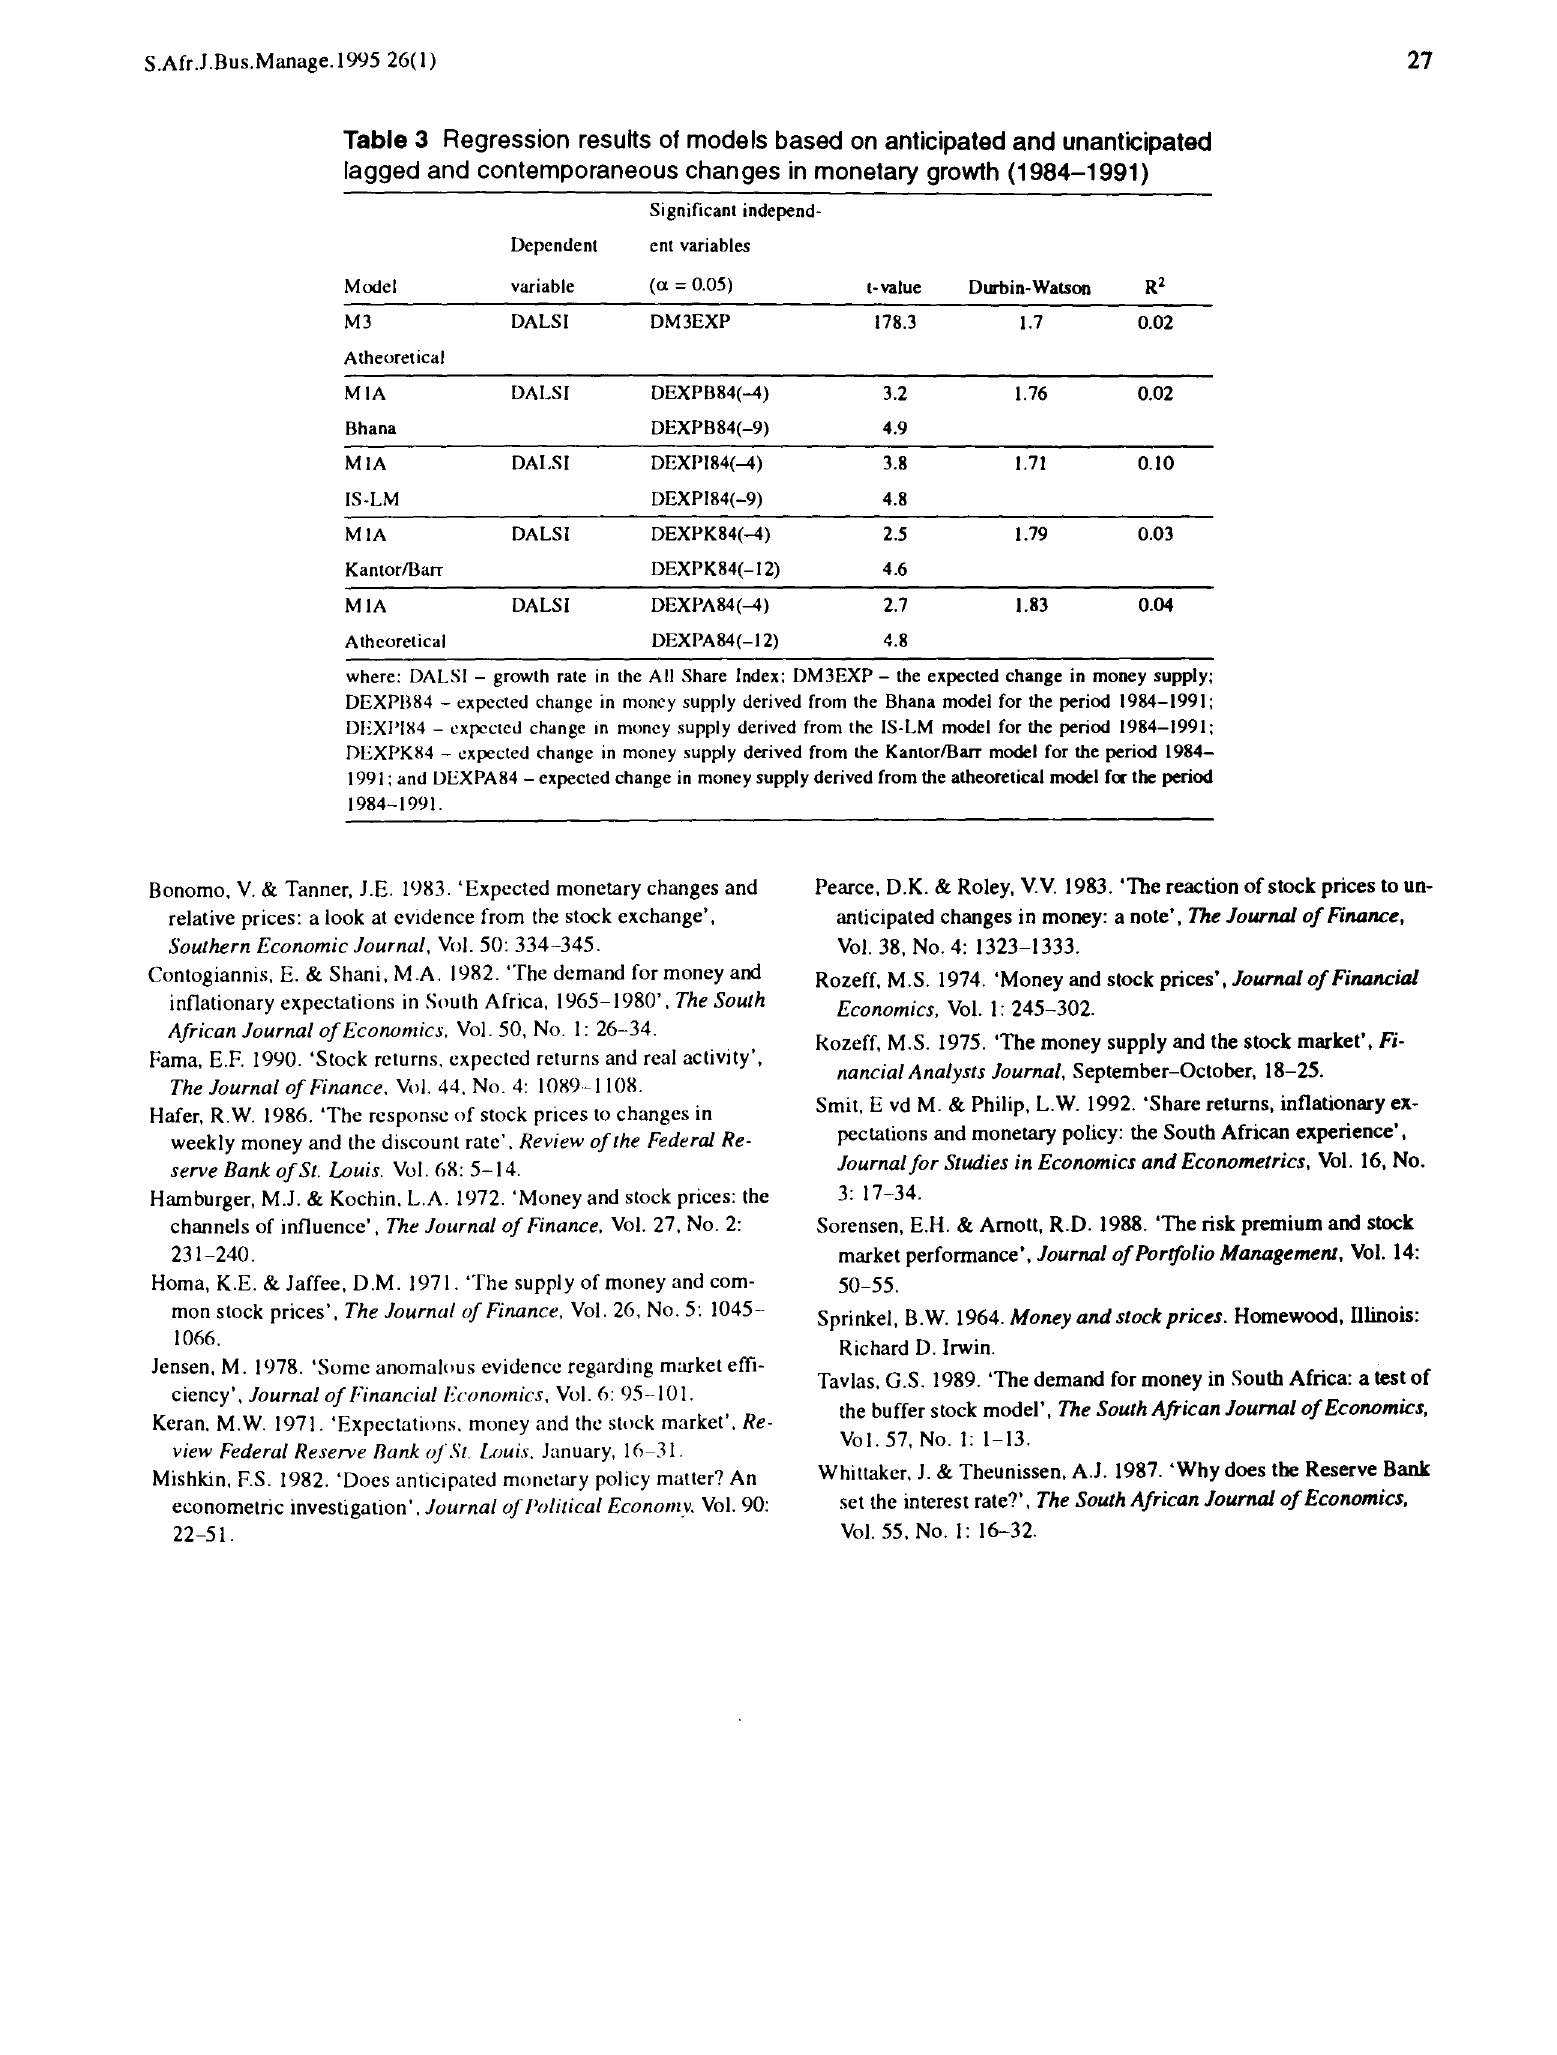
Table 3 Regression results of models based on anticipated and unanticipated lagged and contemporaneous changes in monetary growth